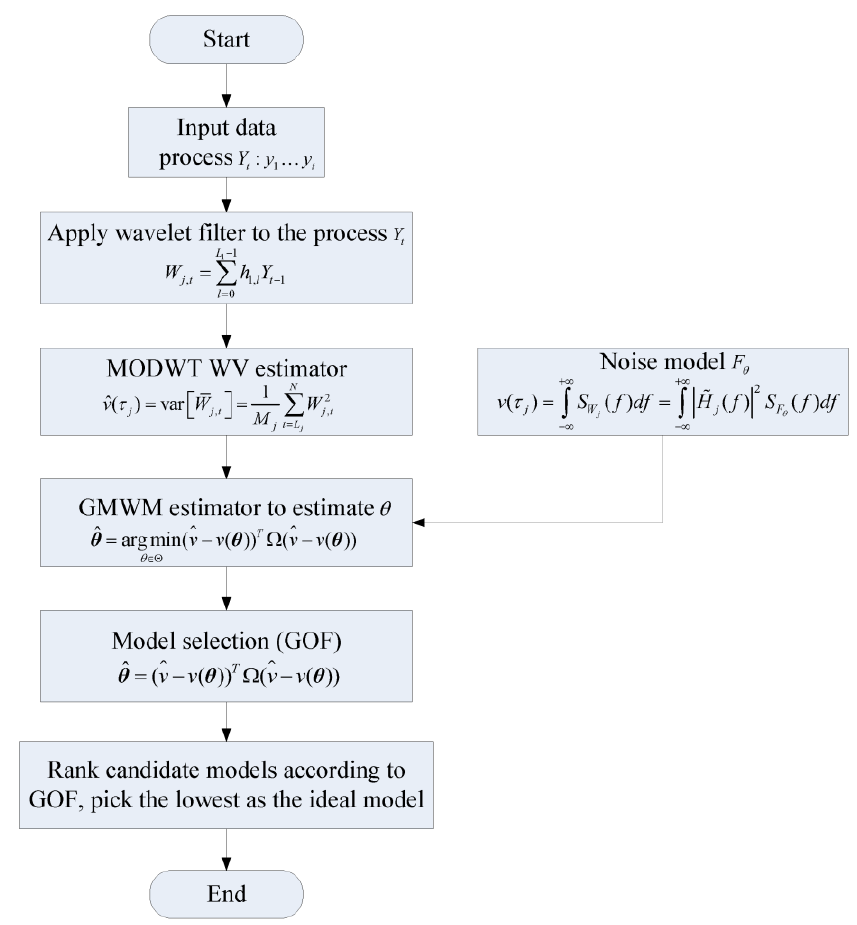
Figure 2. The overall flow of autonomous stochastic error modeling of inertial sensors.